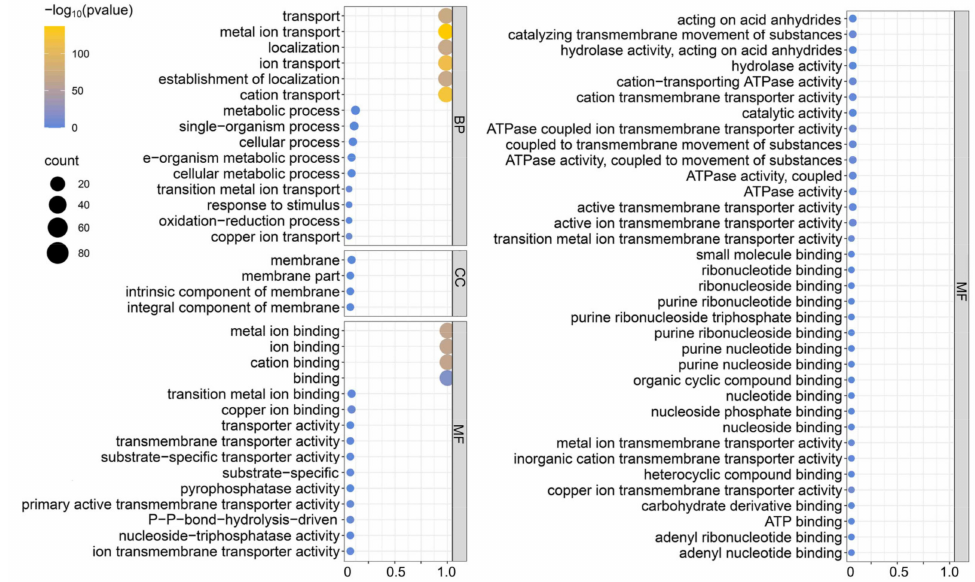
Figure 5. Gene Ontology analysis of BrHMP genes with enrichment in MF (molecular function), BP (biological process), and CC (cellular component) categories. The color and the size of the circles indicate the reliability of the prediction